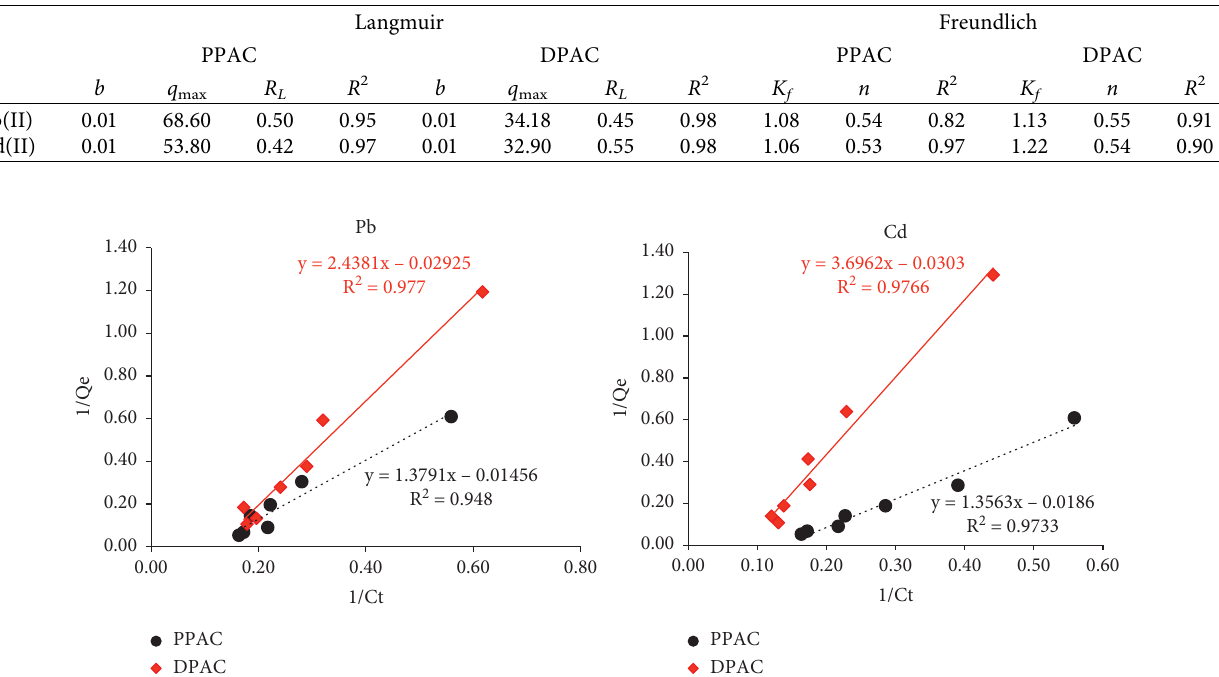
Figure 10: Langmuir isotherm plot for adsorption of Pb(II) and Cd(II) ions by the DPAC and PPAC